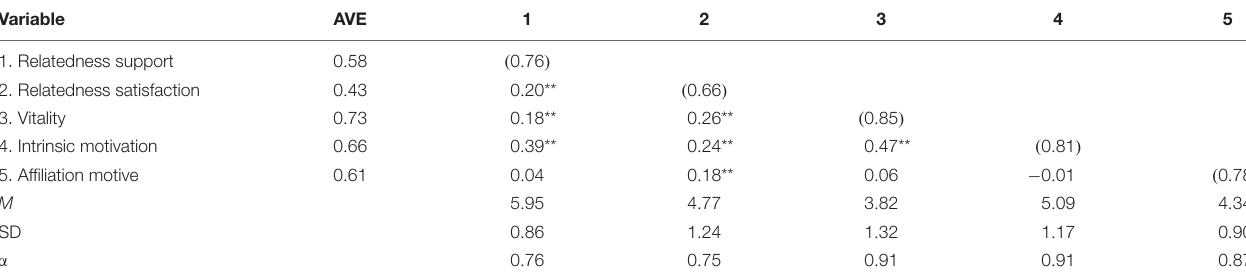
TABLE 2 | Means, standard deviations, AVE, square root of AVE, and manifest bivariate correlations of the variables included in the analyses (Pairwise). Variable